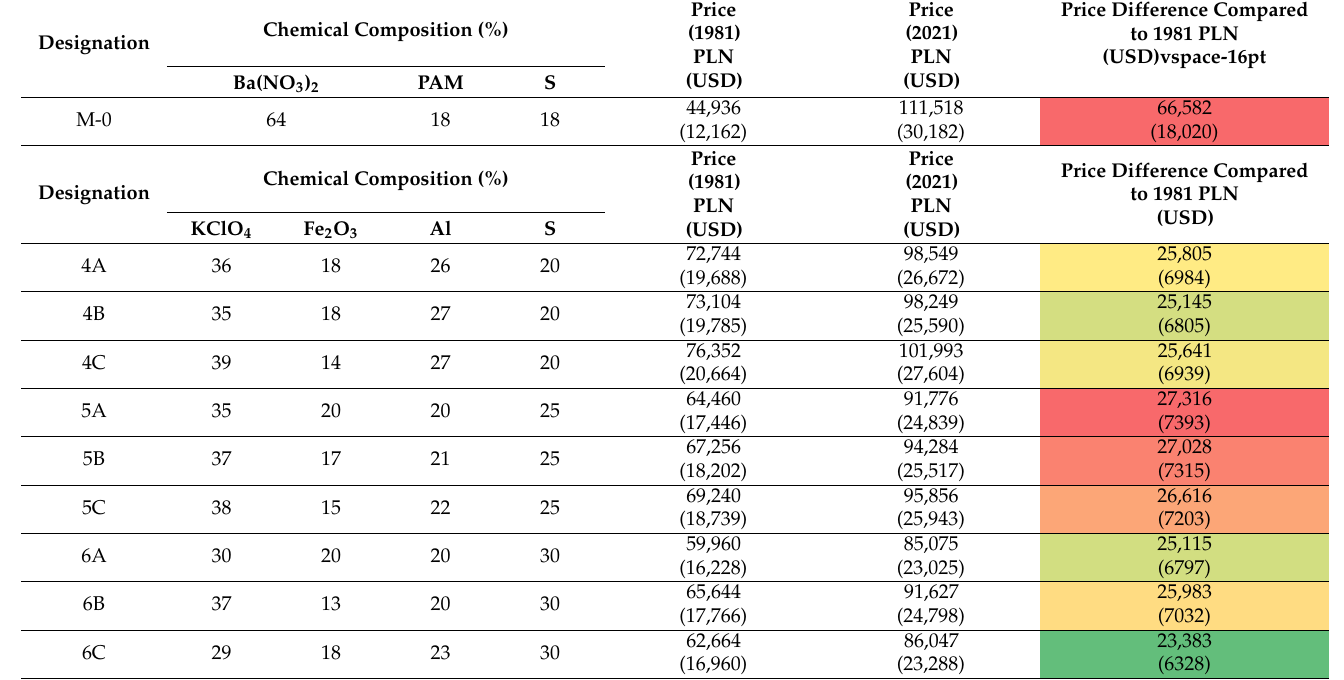
Table 12. Comparison of manufacturing costs of pyrotechnic compositions from the M-2 group for model 2, batch of 2000 kg (4409 lb) of pyrotechnic